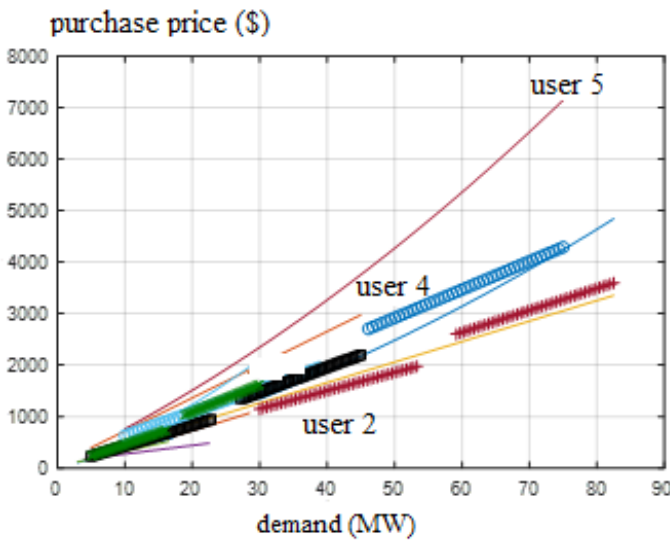
Figure 4. Bidding curves of user aggregators in Case 2. Table 6. Bidding curves of the different user aggregators.